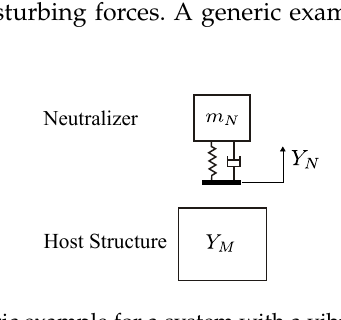
Figure 1. Generic example for a system with a vibration